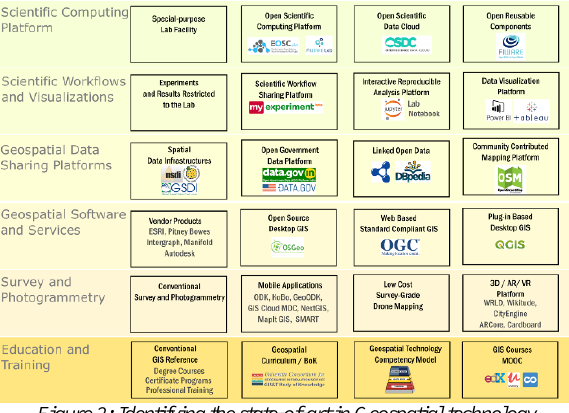
Figure 2: Identifying the state-of-art in Geospatial technology Landscape Surveying and Photogrammetry is key component in Geospatial technology domain, therefore, state-of-the-art in this